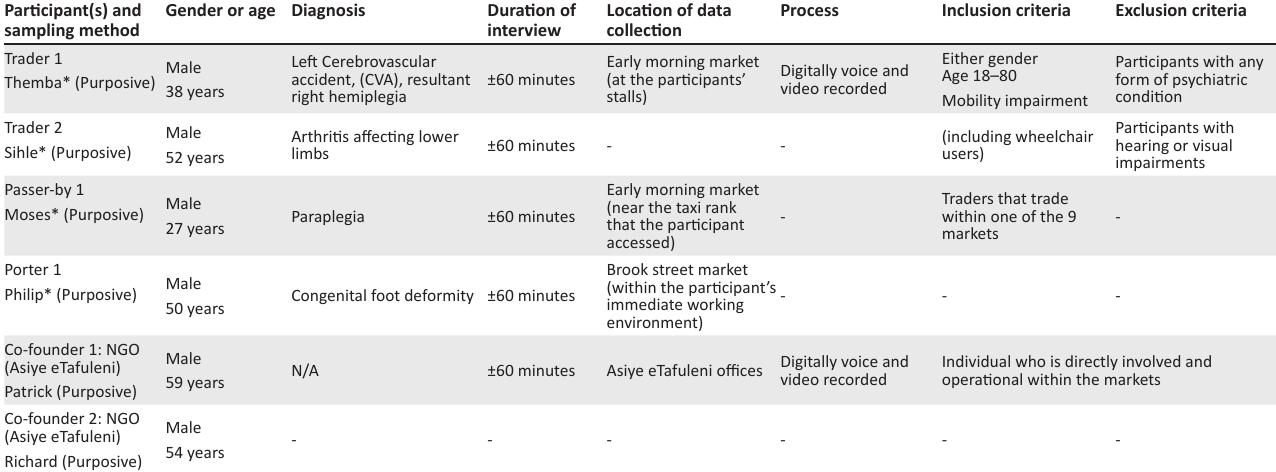
TABLE 1: Overview of methods and participants. Participant(s) and sampling